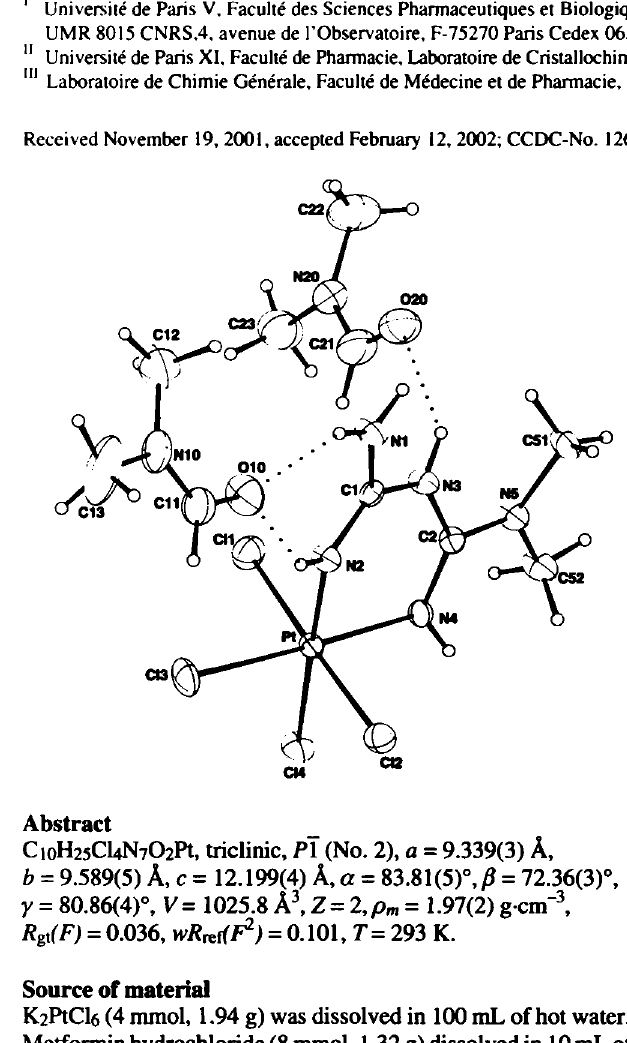
Table 1. Data collection and